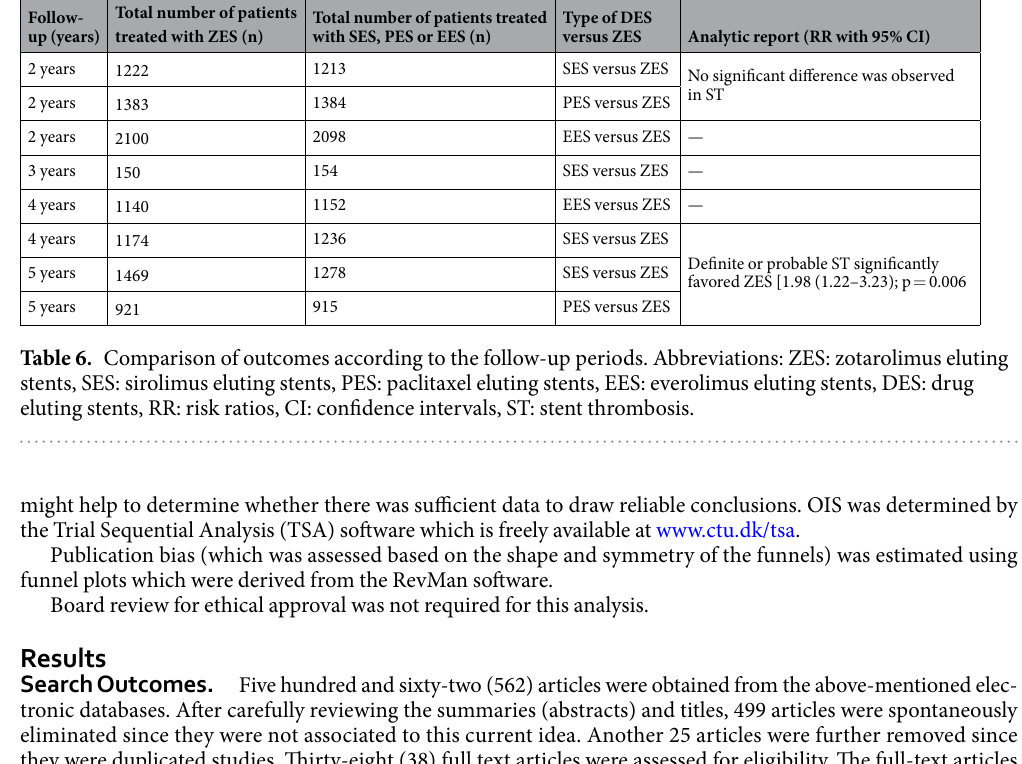
Type of DES versus ZES Analytic report (RR with 95% CI)